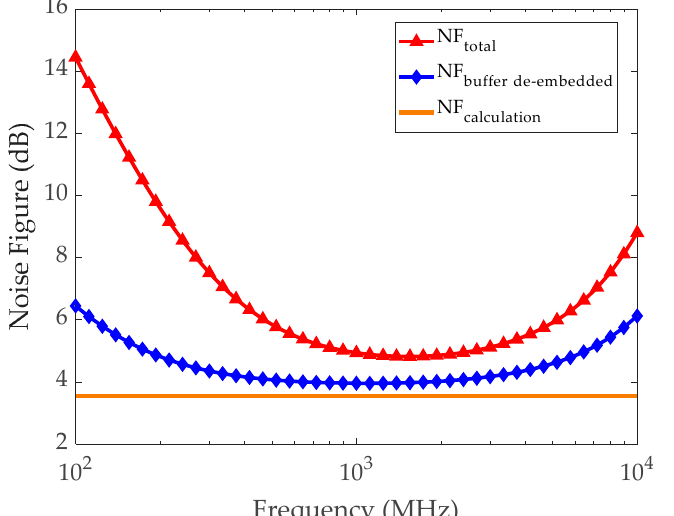
| / | S | ) and power gain ( | S 22 11